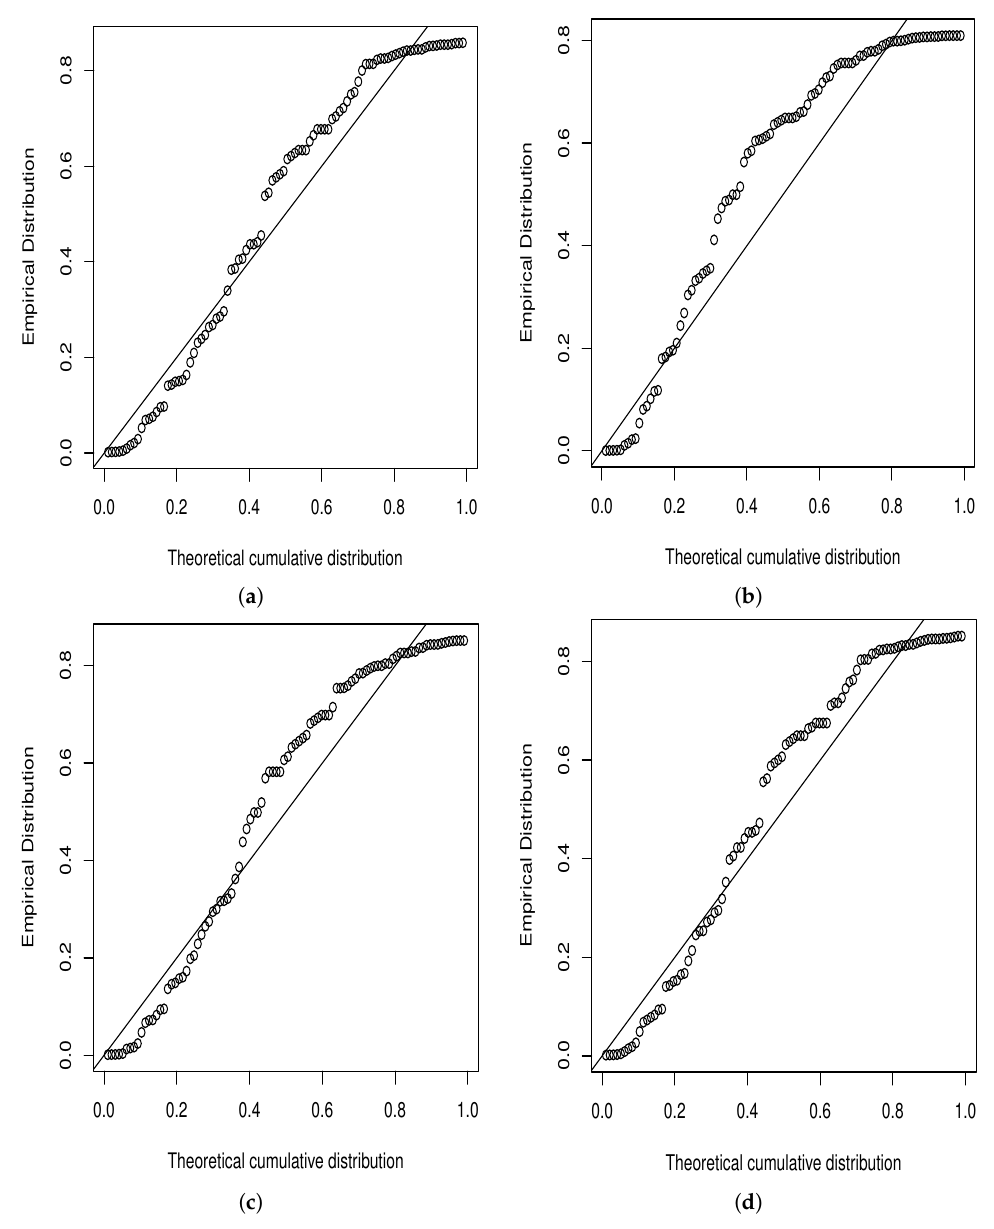
Figure 5. PP Plots for the distributions ( a ) EGD; ( b ) GLED; ( c ) EGLED; and ( d )